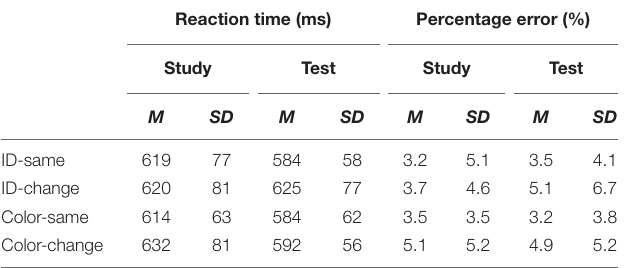
TABLE 1 | Means of median reaction times, expressed in milliseconds (ms), and percentage of errors (%) for the classification of words in Experiment 1.